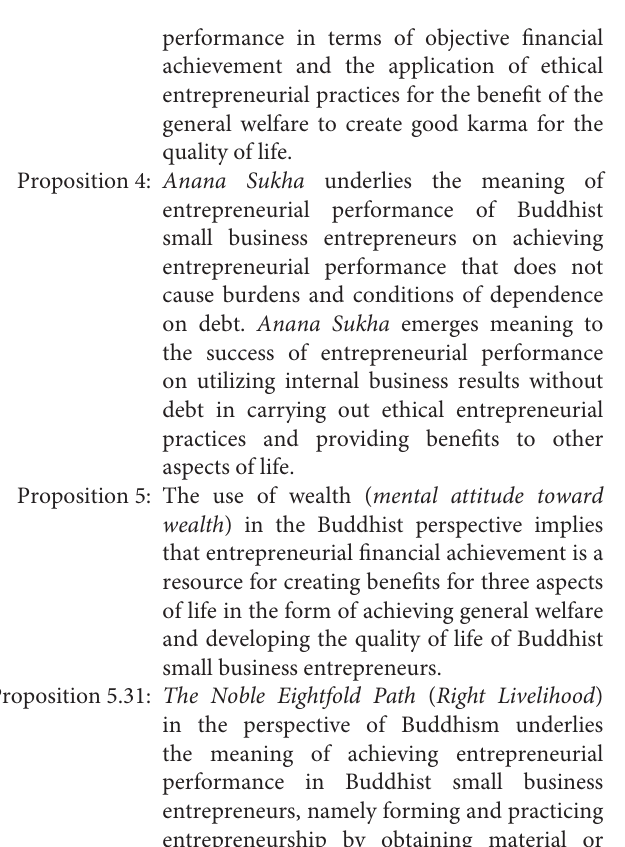
performance in terms of objective